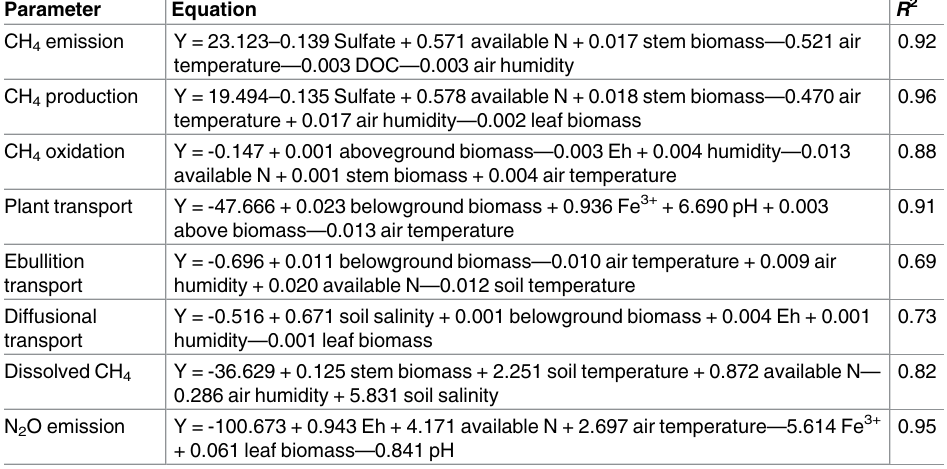
Table 3. Equations of stepwise regression analysis for CH 4 metabolism and N 2 O emission with envi- ronmental